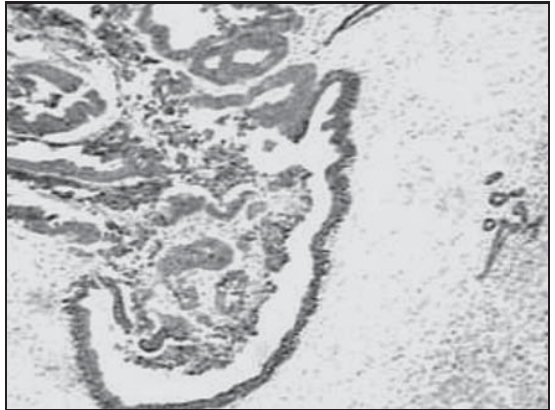
Figura 1 – Fígado com metástase de adenocarcinoma colorretal: positividade para CK 19 em células neoplásicas e em epitélio de ductos